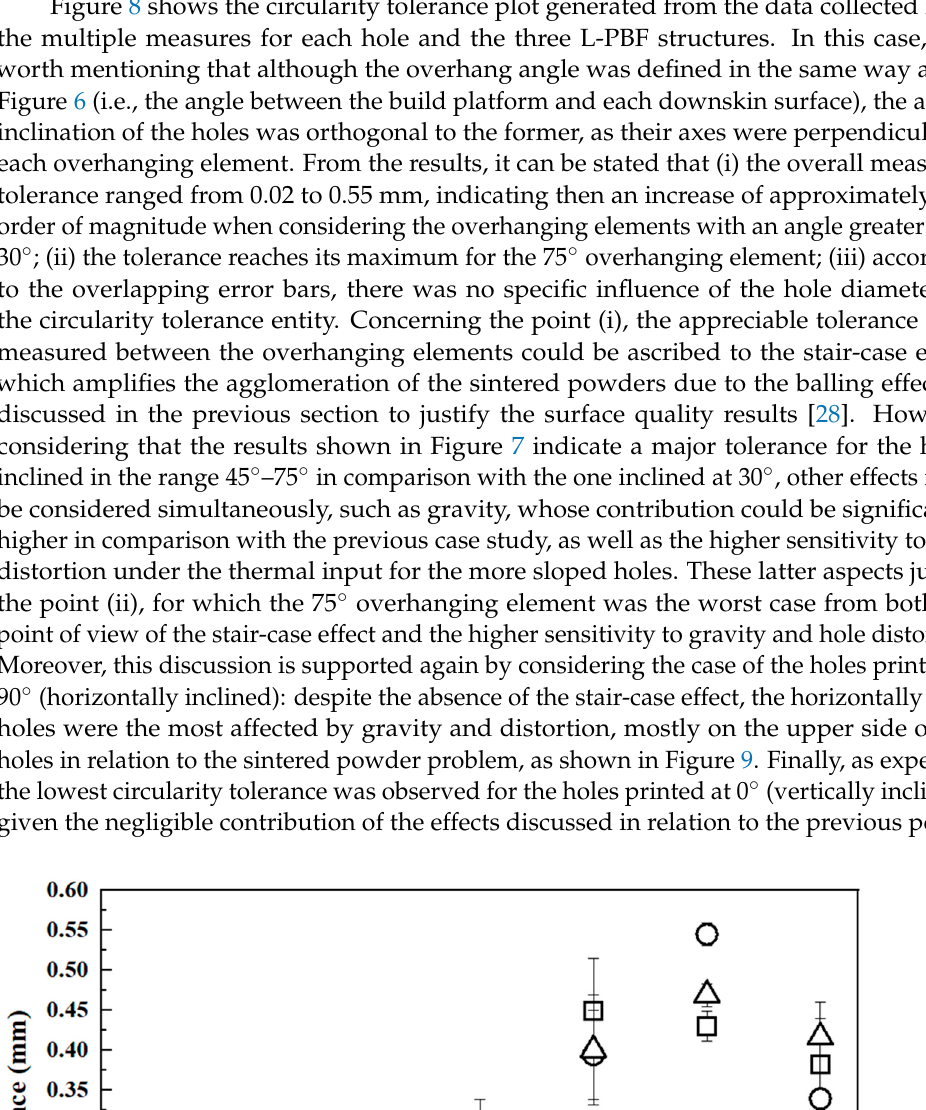
Figure 7. SEM images showing the surface morphology comparison between the overhanging ele- ments of a self-supported L-PBF structure (100× magnification).